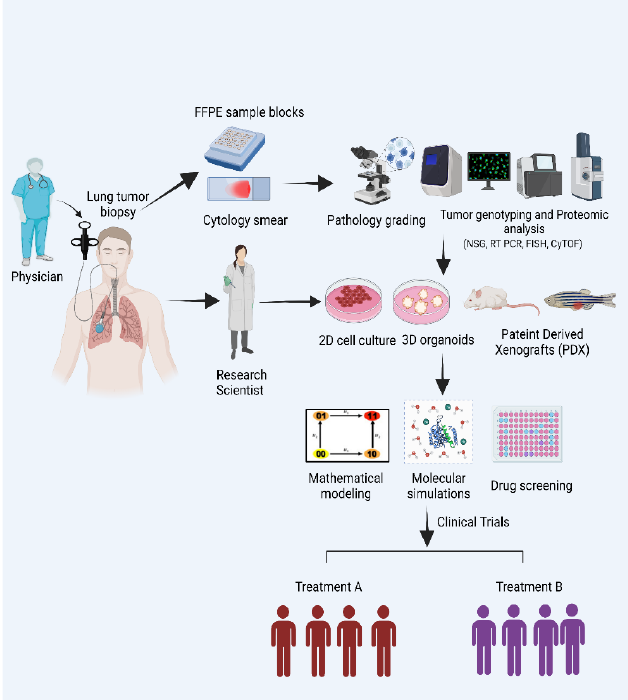
Figure 1. Schematic representing the ‘ Team Medicine ’ approach.